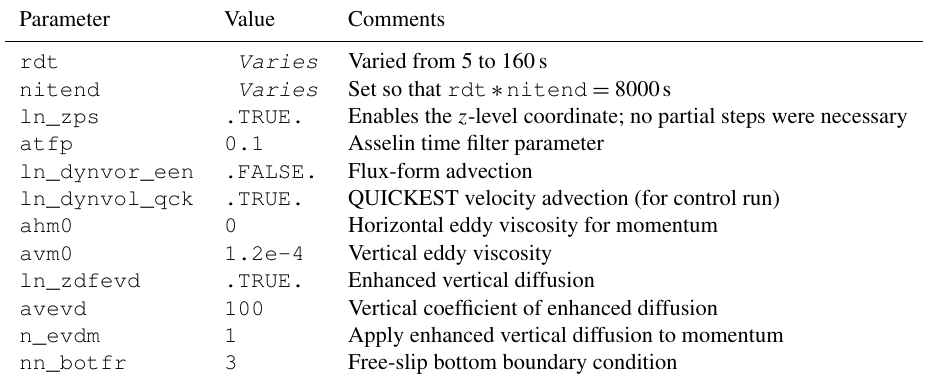
Table 1. Selected namelist parameters for the test case of Sect. 5.1. Parameter Value Comments rdt Varies Varied from 5 to 160s nitend Varies Set so that rdt ∗ nitend = 8000s ln_zps .TRUE. Enables the z -level coordinate; no partial steps were necessary atfp 0.1 Asselin time filter parameter ln_dynvor_een .FALSE. Flux-form advection ln_dynvol_qck .TRUE. QUICKEST velocity advection (for control run) Horizontal eddy viscosity for momentum 1.2e-4 Vertical eddy viscosity .TRUE. Enhanced vertical diffusion 100 Vertical coefficient of enhanced diffusion Apply enhanced vertical diffusion to momentum Free-slip bottom boundary condition